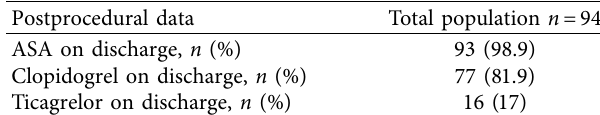
Table 4: Postprocedural data.